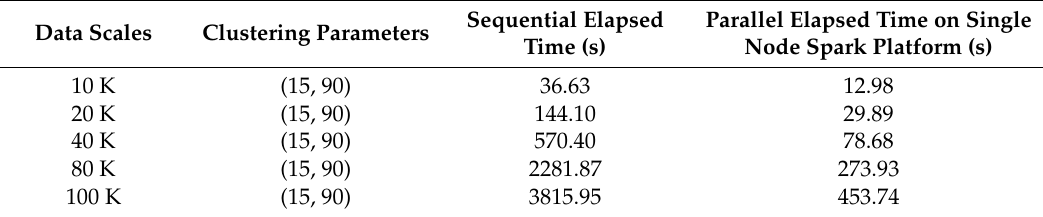
Table 7. Running time of serial and parallel DBSCAN algorithm based on a single-node Spark